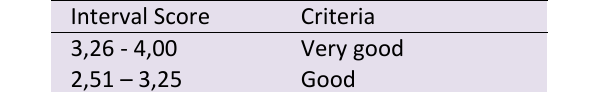
Table 6 . Guidelines for Scoring 1-4